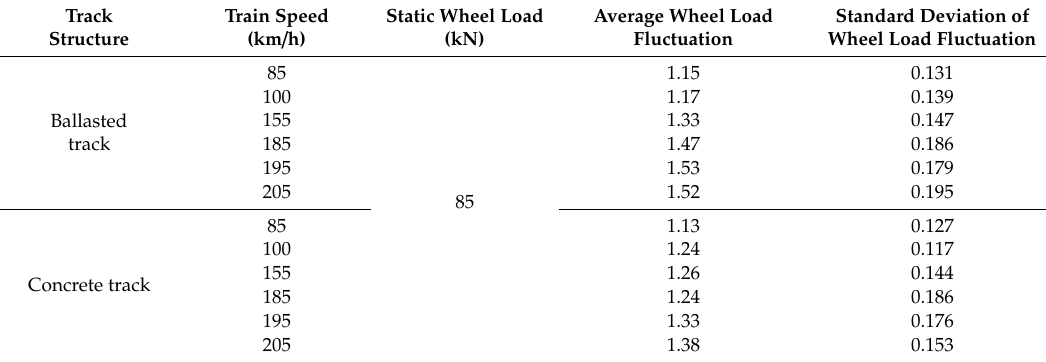
Figure 11. Standard deviation of wheel load fluctuation comparison, ( a ) ballasted track DAF Field result. ( b ) concrete track DAF Field result. Table 14. Dynamic Stability Evaluation Parameter Comparison of Ballasted and Ballast-less tracks.